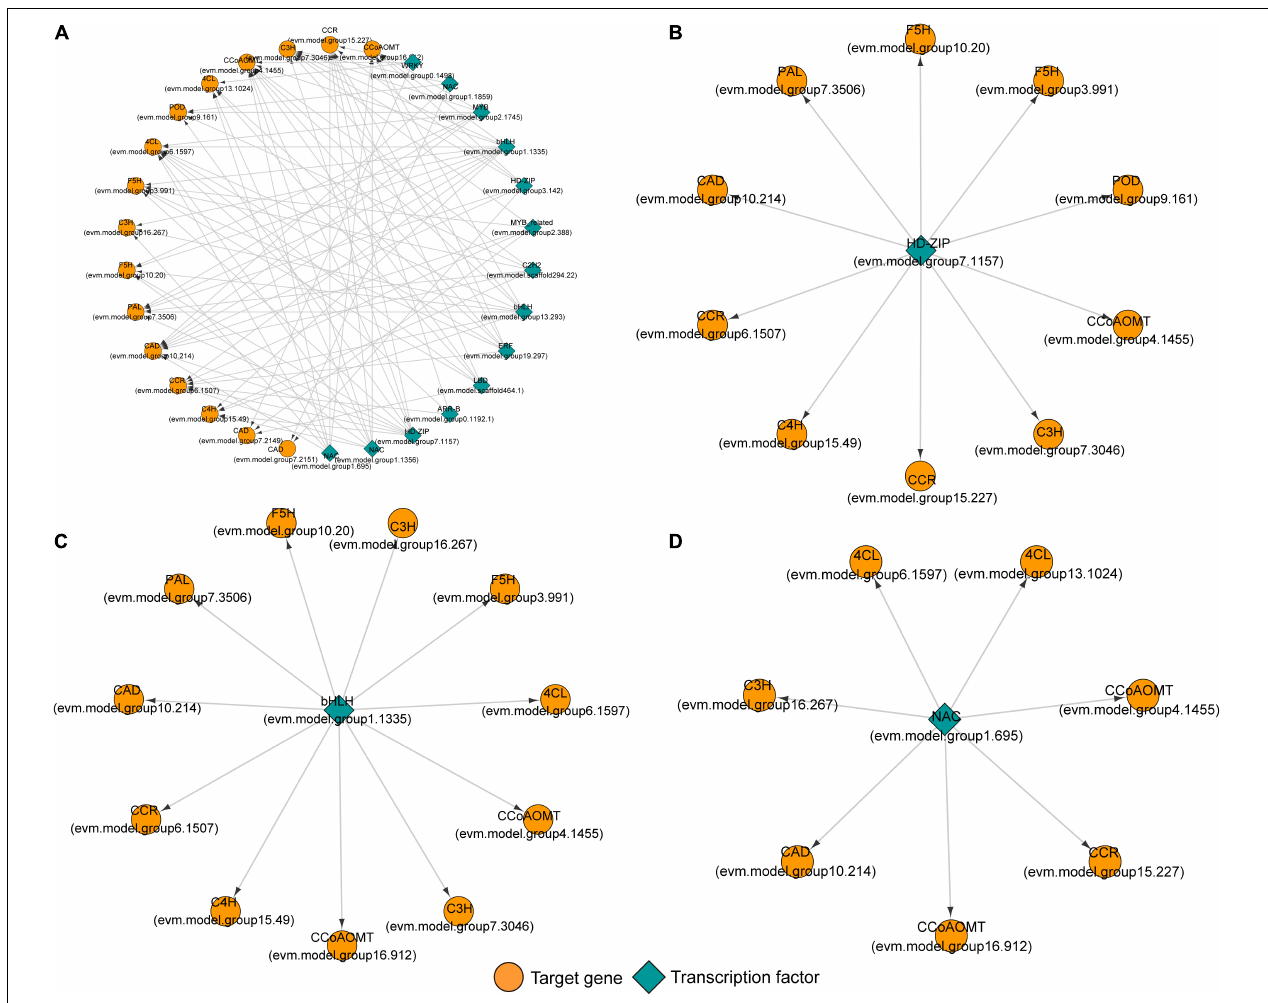
FIGURE 8 | The potential regulatory network between transcription factors and genes involved in lignin monomer biosynthesis in tension wood (TW) formation. (A) The regulatory network between candidate transcription factors and 17 key genes involved in lignin monomer biosynthesis. (B) The regulatory network of key HD-ZIP transcription factors and target genes. (C) The regulatory network of key bHLH transcription factors and target genes. (D) The regulatory network of key NAC transcription factors and target